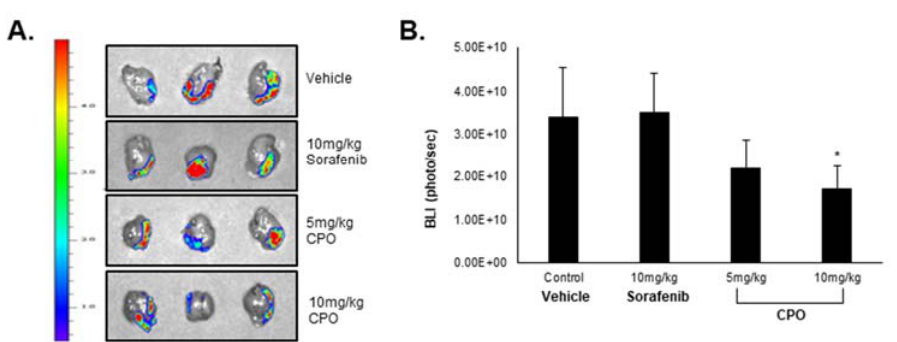
Figure 7. Efficacy of chromenopyrimidinone (CPO) in an orthotopic hepatocellular carcinoma mouse model. ( A ) HCC tumor size in the mouse model after being treated with 5 mg / kg and 10 mg / kg of CPO for 2 weeks. The fluorescence in the tumor images is bioluminescence (BLI) through optical imaging system. ( B ) The intensity of BLI in each group. Data are expressed as mean ± SD; * p < 0.05 compared to control group.